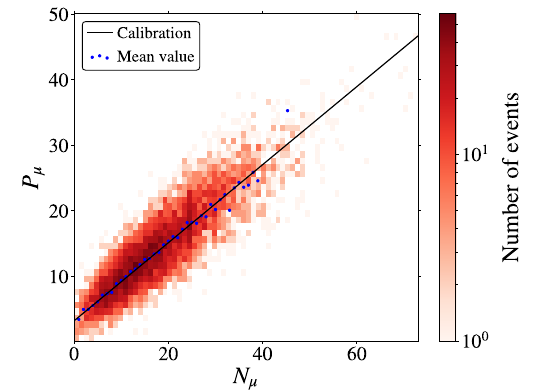
(cid:7) N S N ( i ) μ and i = 0 Fig. 8 Resolution and bias of the calibration between N μ and P